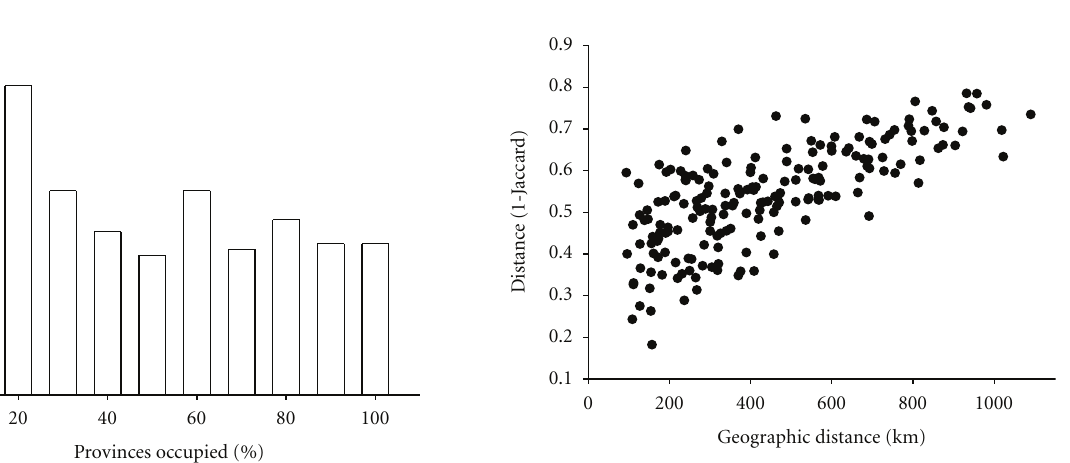
Figure 2: Occupancy frequency distribution of Finnish crane flies (Diptera, Tipuloidea, 334 spp.) in the biogeographical provinces ( n = 20).